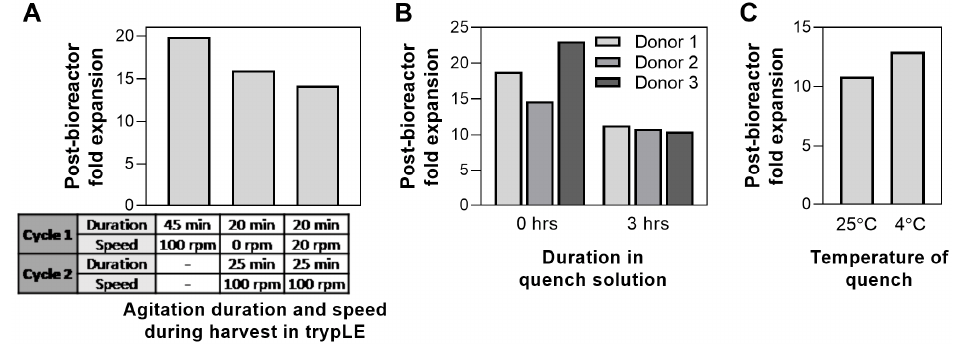
Figure 6. Effect of various bioreactor harvest conditions on post-harvest cell health: ( A ) agitation duration and speed during harvest in TrypLE, ( B ) duration in quench solution, and ( C ) temperature of quench solution.